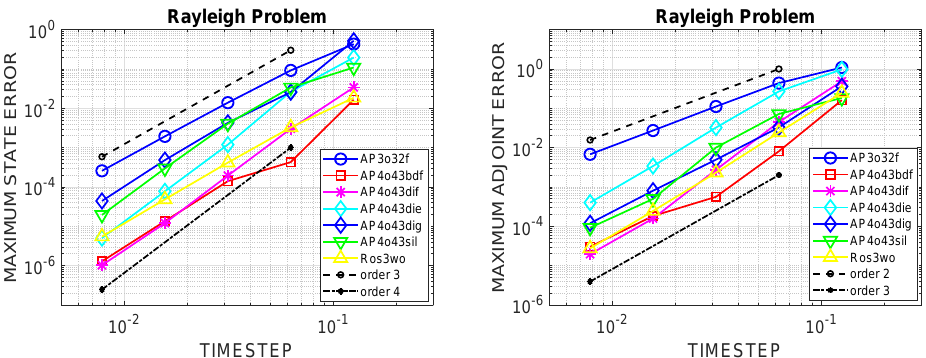
Figure 1. Rayleigh Problem: Convergence of the maximal state errors (cid:107) ( w T ⊗ I ) Y n − y ( t n + 1 ) (cid:107) ∞ ( left ) and adjoint errors (cid:107) ( v T ⊗ I ) P n − p ( t n ) (cid:107) ∞ ( right ), n = 0, . . . , N